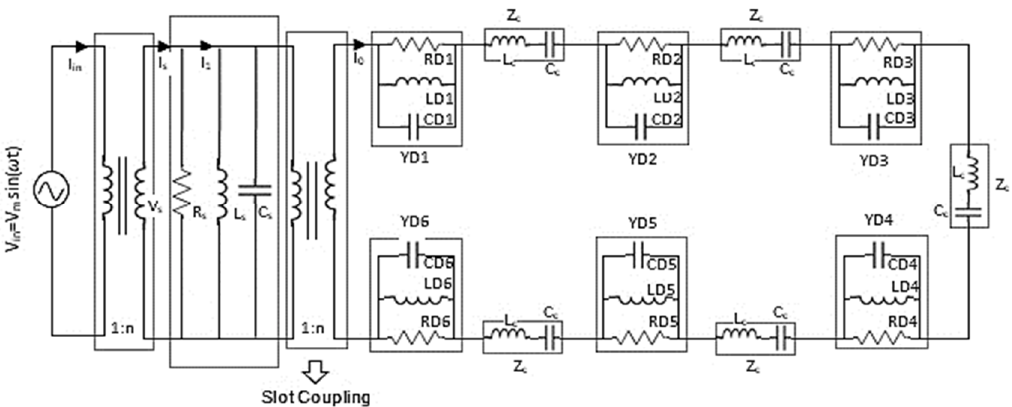
Figure 1. Multi-stacked DRA equivalent circuit.